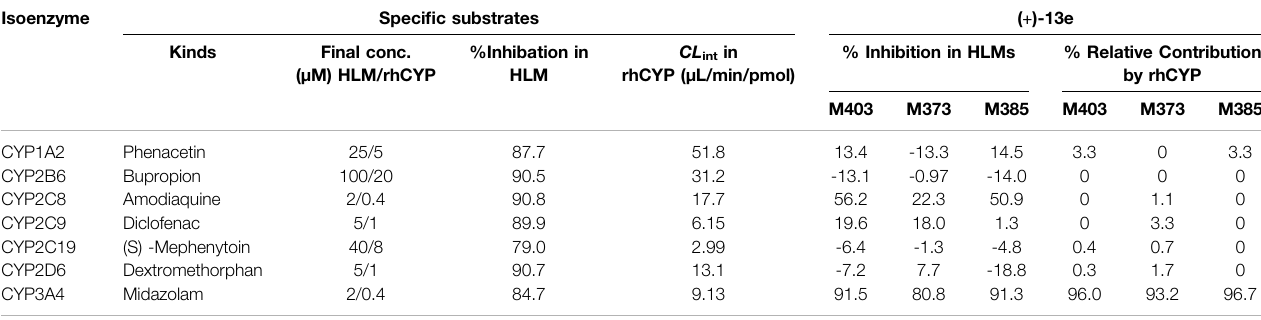
TABLE4| RelativecontributionofindividualcytochromeP450isoformstogenerationofthemetabolitesM403(mono-oxidizedproduct),M373(demethylatedproduct), and M385(dehydrogenatedproduct)from(+)-9-tri fl uoroethoxy- α -dihydrotetrabenazine[(+)-13e]inhumanlivermicrosomesandrecombinantlyexpressedcytochromeP450 (rhCYP) isozymes.